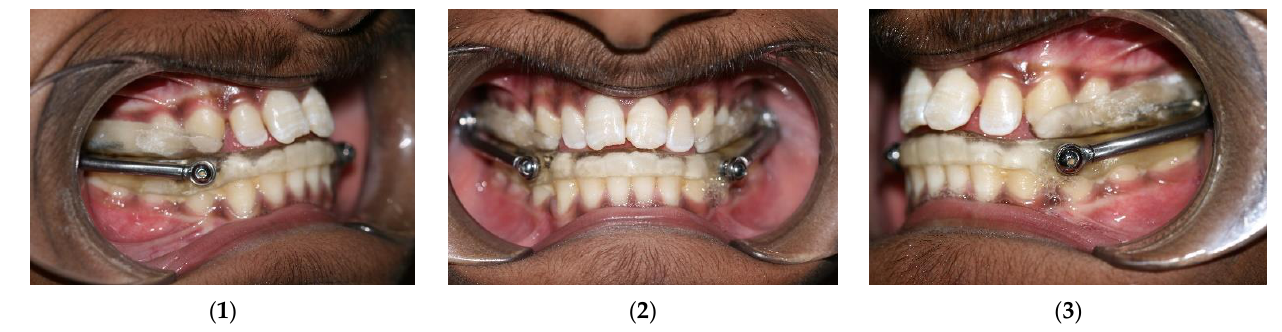
Figure 1. Herbst appliance: ( 1 ) right intraoral; ( 2 ) frontal intraoral; and ( 3 ) left intraoral. Scans were carried out with I-CAT Cone Beam 3D Dental Imaging system (I-CAT Table 1. Shows pre-treatment statistical comparison for Group 1 and Group 2. Classic, Imaging Sciences International, Hatfield, PA, USA), operated at 90 kv and 14 mA with field of view (FOV) of 200 × 160 mm and voxel size of 0.3 mm. DICOM images were imported to In Vivo Dental 5.2.4 software (Anatomage, anatomy imaging software, San Jose, CA, USA). Scans from Group 1 and Group 2 were analysed by a single blinded examiner. The scans were standardised on volume rendered view using two reference planes, a transverse and a coronal plane (Figure 2(1–3)). For the transverse plane, the orientation grid was bilaterally placed through porion and orbitale on both right and left sides. For the coronal plane, the orientation grid was bilaterally placed tangent to posterior surface of right and left pterygomaxillary fissures (pterygoid vertical